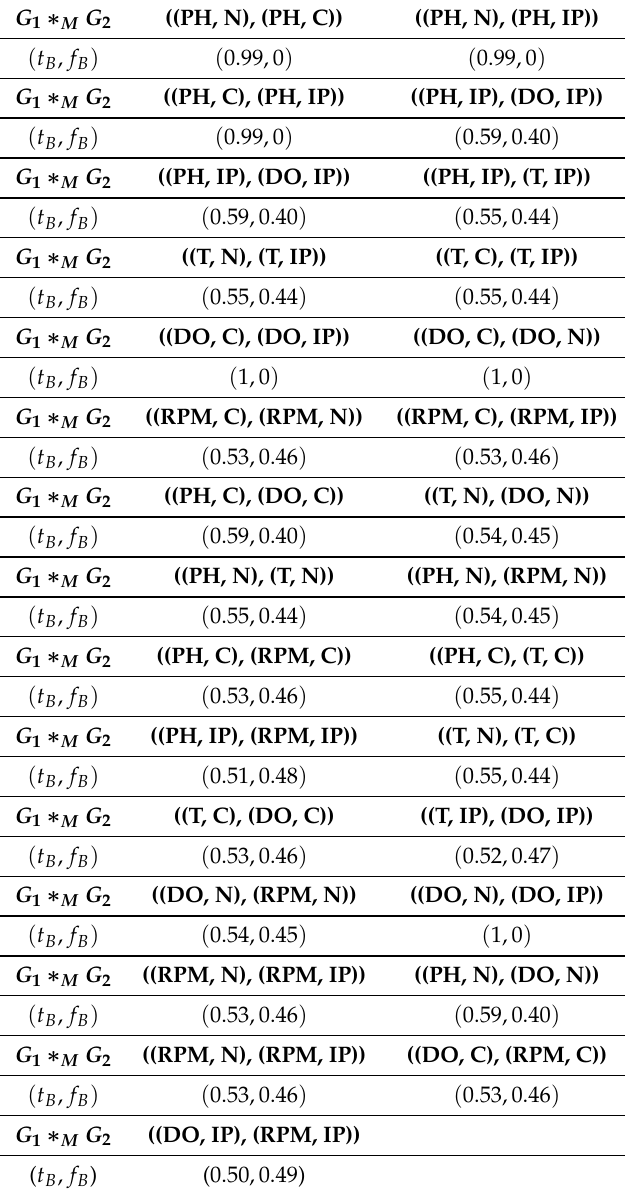
Table 7. Degree of edges in vague graph G 1 ∗ M G 2